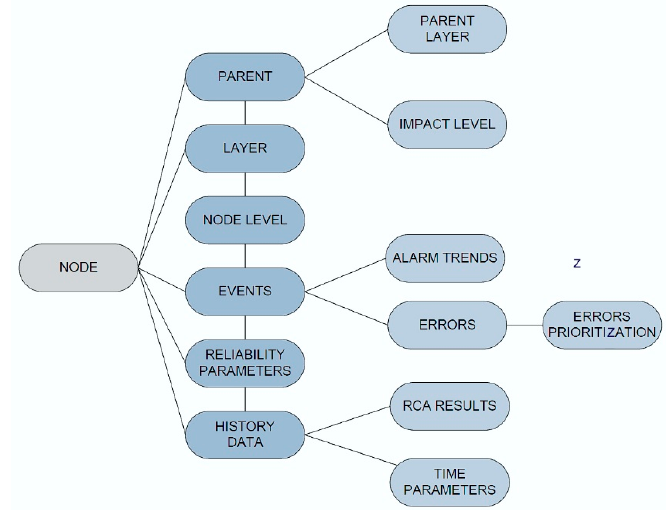
Figure 3. Node model with possible entities.